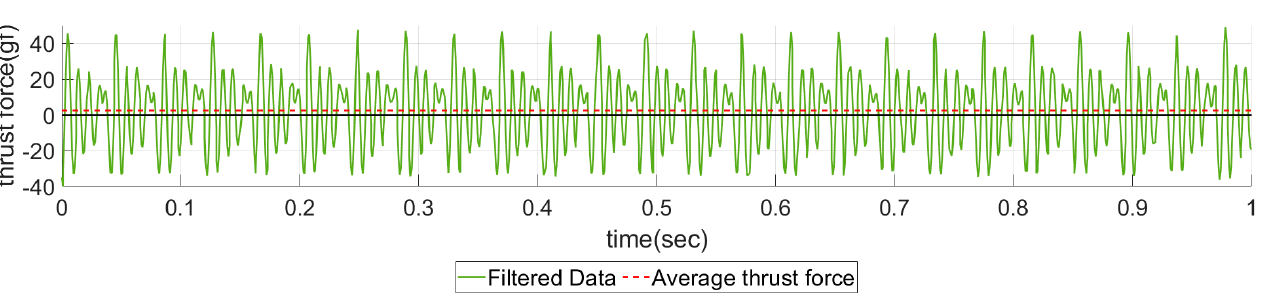
Figure 12. The measured thrust. The low ‐ pass filtered data (solid line) and the average value (dashed line) are given.